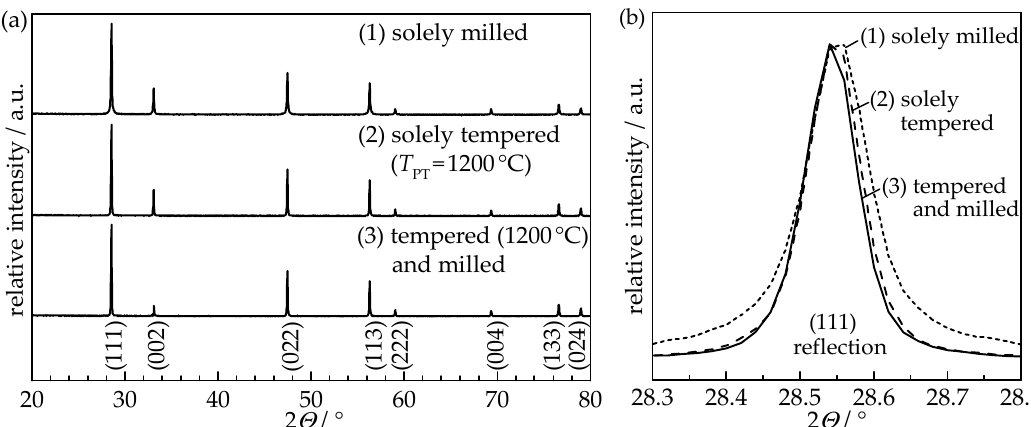
Figure 1. X-ray diffraction (XRD) patterns of pretreated GDC10 powders used for aerosol deposition: ( a ) complete 2 Θ range from 20° to 80° and ( b ) (111) reflection at 2 Θ = 28.5° (2 Θ range from 28.3° to 28.8°). Note: GDC = gadolinium-doped ceria.